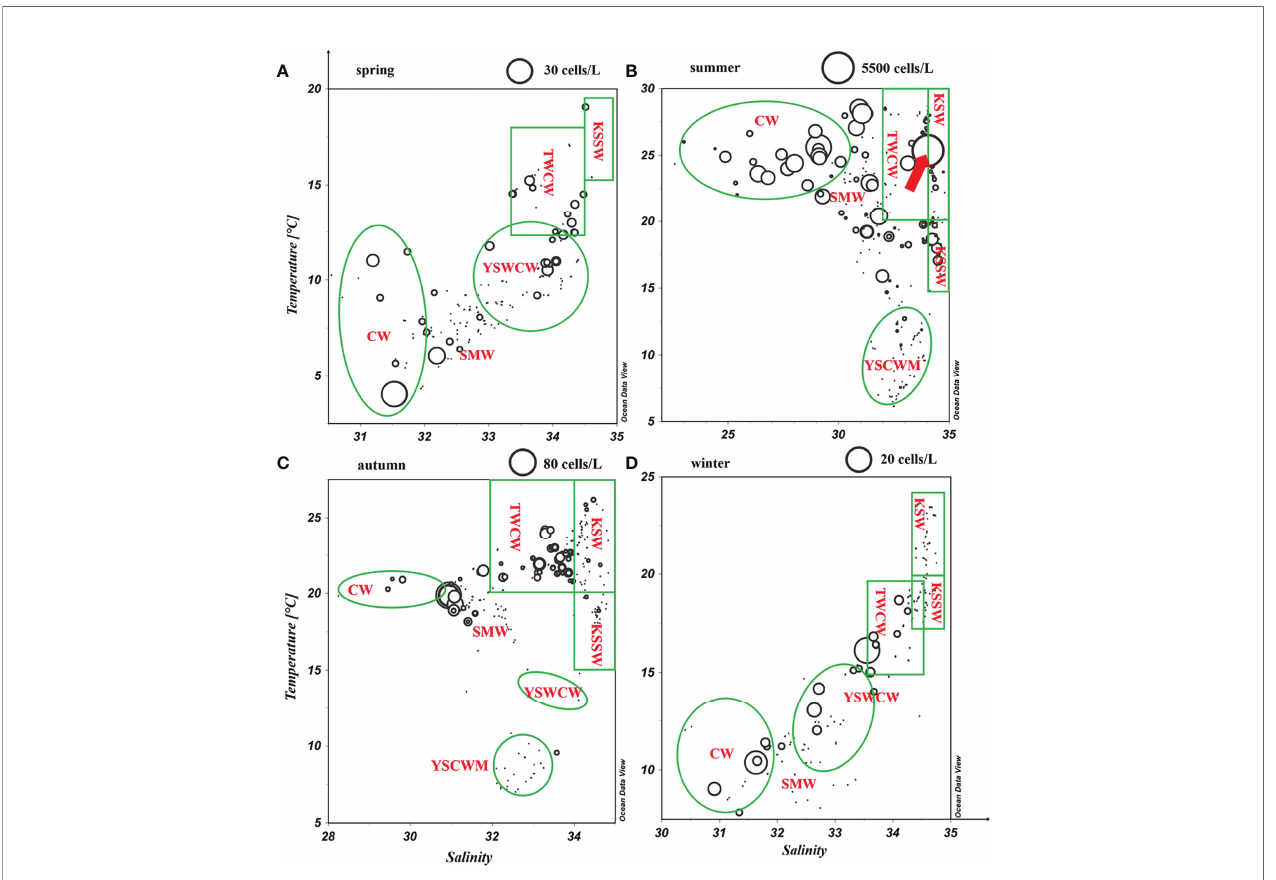
FIGURE 6 | Diagram of N. scintillans abundance (cells/L) versus temperature – salinity (water masses) in the East China Sea and southern Yellow Sea. The arrow indicates a bloom of N. scintillans with abundance of 5314 cells/L at station T07. CW: including Changjiang Diluted Water, the ECS Coastal Water, and the SYS Coastal Water; YSWCW, Yellow Sea Warm Current Water; TWCW, Taiwan Warm Current Water; YSCWM, the deeper Yellow Sea Cold Water Mass; KSW, Kuroshio surface water; KSSW, Kuroshio subsurface water; SMW, shelf mixed water. (A) spring; (B) summer; (C) autumn; (D)